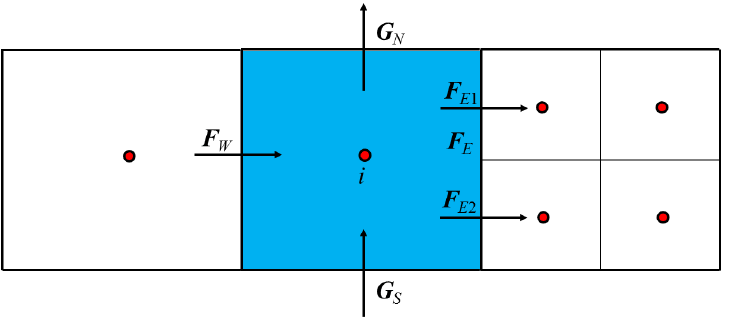
Figure 2. Non-uniform rectangular control element i